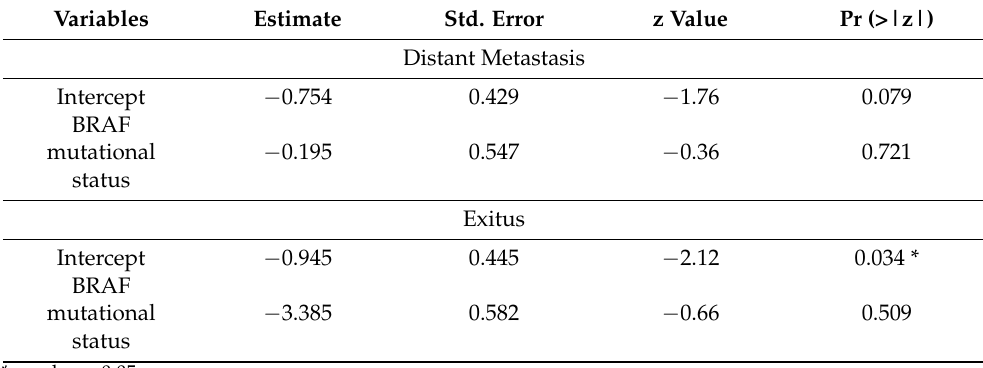
Table 2. Univariate logistic regression analysis for distant metastasis and exitus depending on BRAF mutational status. Variables Estimate Std. Error